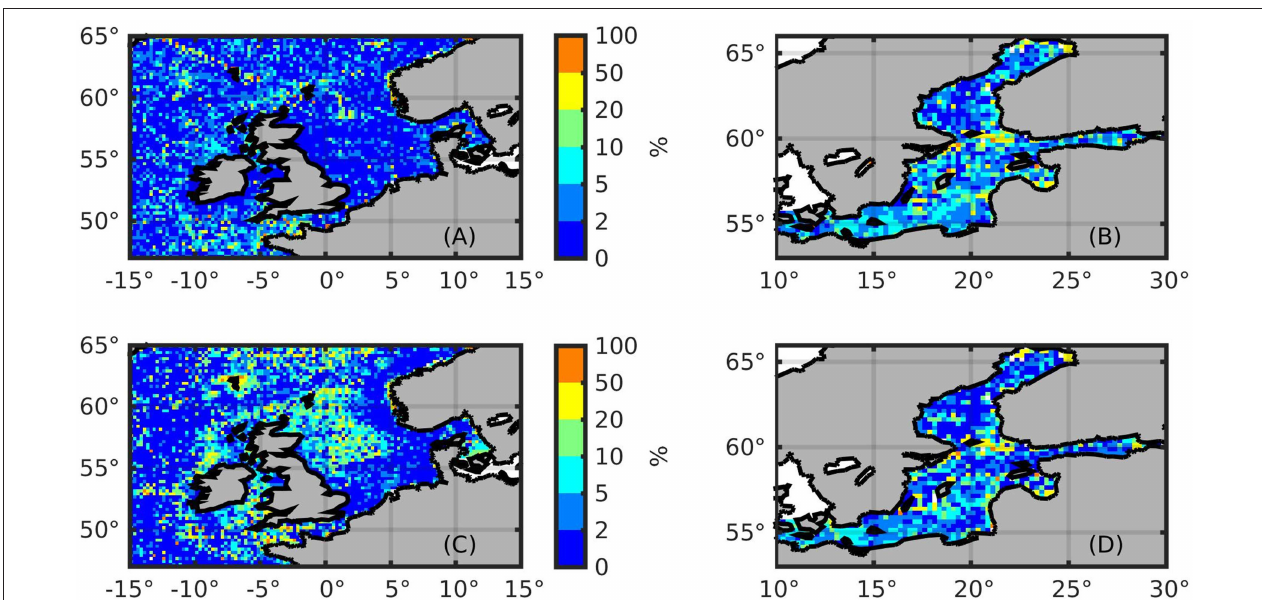
TABLE 2 | Results of the quality control for the North and the Baltic Sea and the two parameters temperature and salinity: summary.